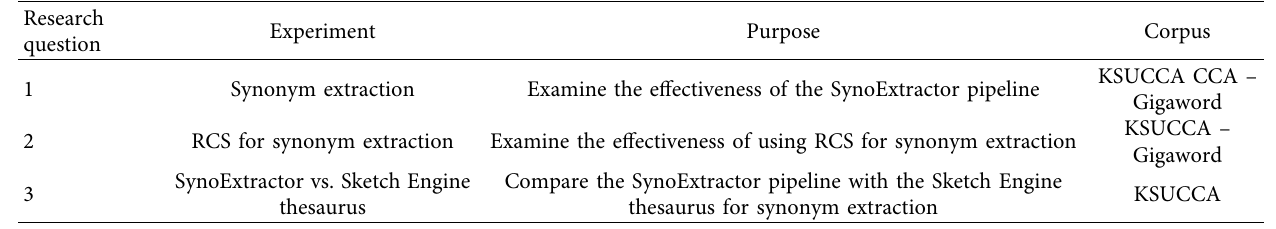
Table 12: The Llist of synonym extraction